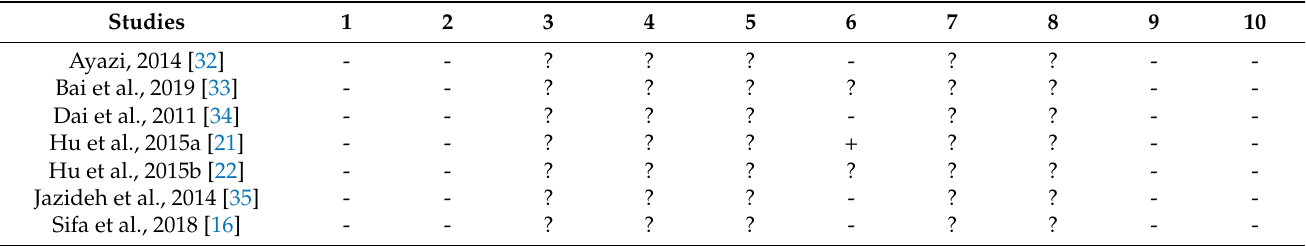
Table 2. Risk of bias assessment according to the SYRCLE’s risk of bias tool for animal